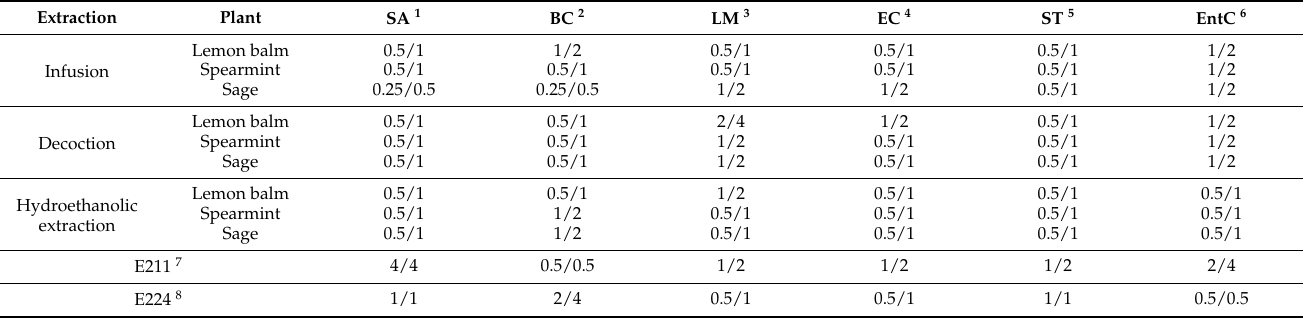
Table 1. Antibacterial activity of plant extracts expressed as minimum inhibitory concentration